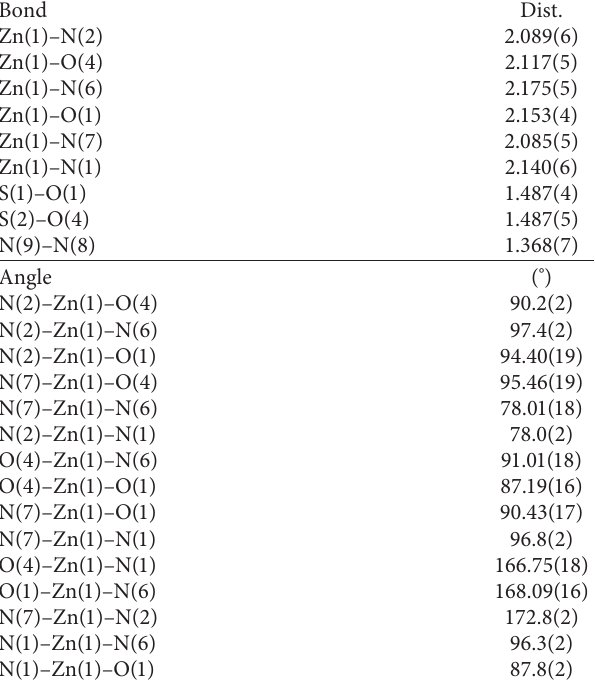
Table 5: Selected bond lengths (˚A) and bond angles ( ° ) of complex